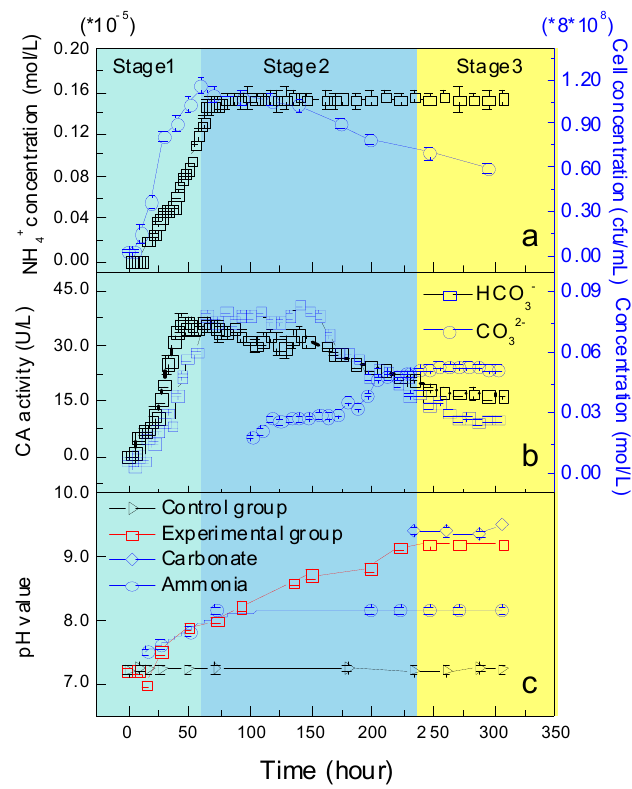
Figure 2. Physiological and biochemical characteristics of SRB2. ( a ) Growth curve of SRB2 and the ammonium concentration; ( b ) CA activity, and the concentration of carbonate and bicarbonate ions; ( c ) pH in the control and experimental group, pH based on the NaHCO 3 + Na 2 CO 3 solution and NH 4 + concentration.